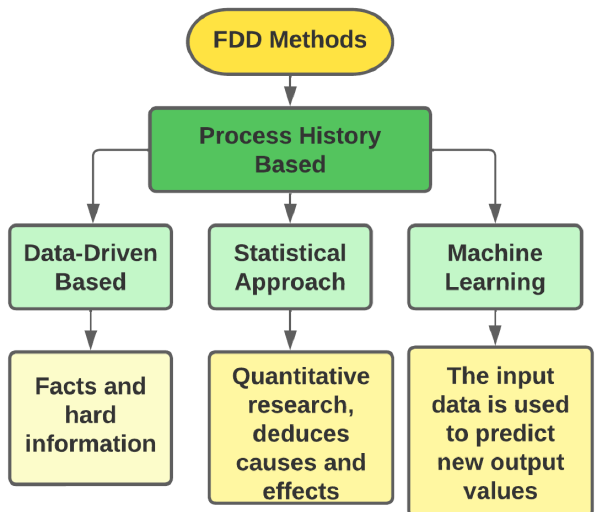
Figure 2. Approaches for fault detection and diagnosis methods. Based on